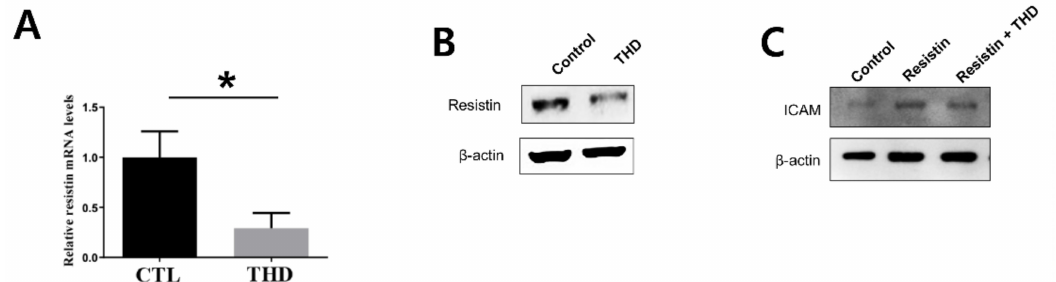
Figure 6. THD inhibits resistin expression and resistin-induced ICAM expression. THP-1 cells were di ff erentiated, and the mRNA ( A ) and protein ( B ) expression levels of resistin were determined ( n = 3). ( C ) HUVECs were activated by resistin treatment, and ICAM-1 expression levels were evaluated ( n = 3). THD, Tongqiaohuoxue decoction; ICAM-1, intercellular adhesion molecule-1. * p < 0.001 vs.